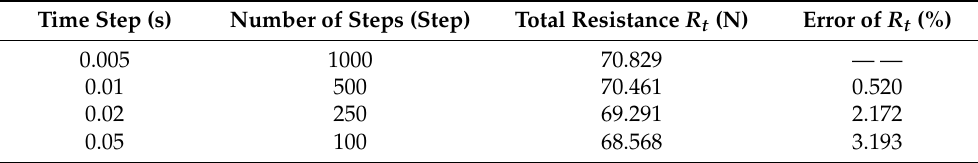
Table 2. Time step convergence analysis for straight navigation.